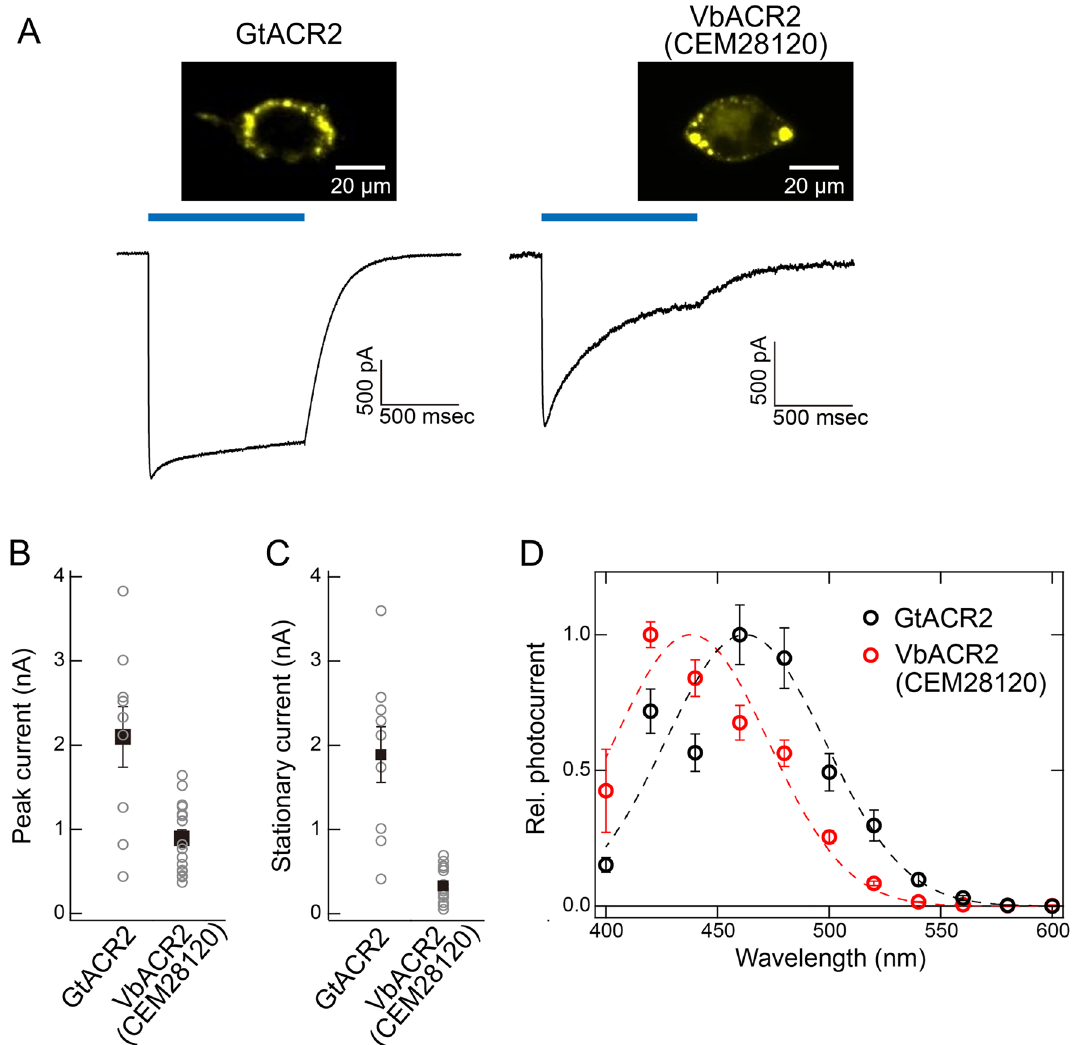
Figure 2. Expression and electrophysiological measurements of VbACR2 and GtACR2. ( A ) Representative photocurrent traces of GtACR2 and VbACR2 (CEM28120) elicited with blue light (blue bars) at the membrane potential of − 60 mV in the standard intracellular and extracellular solutions (146 and 147 mM Cl − in the intracellular and extracellular solution, respectively) (Table S1). Fluorescence images of ND7/23 cells expressing GtACR2 and VbACR2 were also shown. The fluorescence signals derived from EYFP which was fused to the C-terminus of GtACR2 and VbACR2 were monitored. ( B , C ) Peak ( B ) and stationary current amplitudes ( C ) of GtACR2 and VbACR2 elicited with blue light (470–495 nm, 2.0 mW mm −2 ) at the membrane potential of − 60 mV in the standard solutions. The data are mean values ± SEM (n = 9–16 cells). ( D ) Photocurrent action spectra of GtACR2 and VbACR2. The peak current amplitudes were plotted against the wavelength of light. The data are mean values ± SEM (n = 5